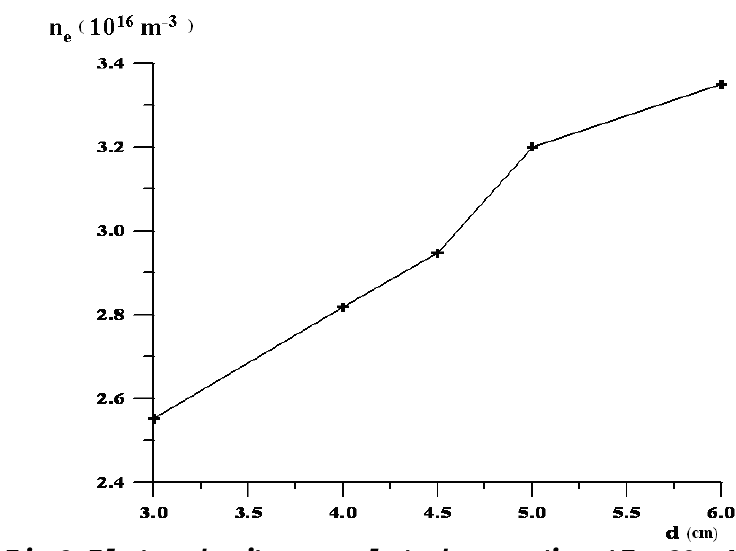
Fig. 6: Electron density versus electrode separation at Id =30 mA.